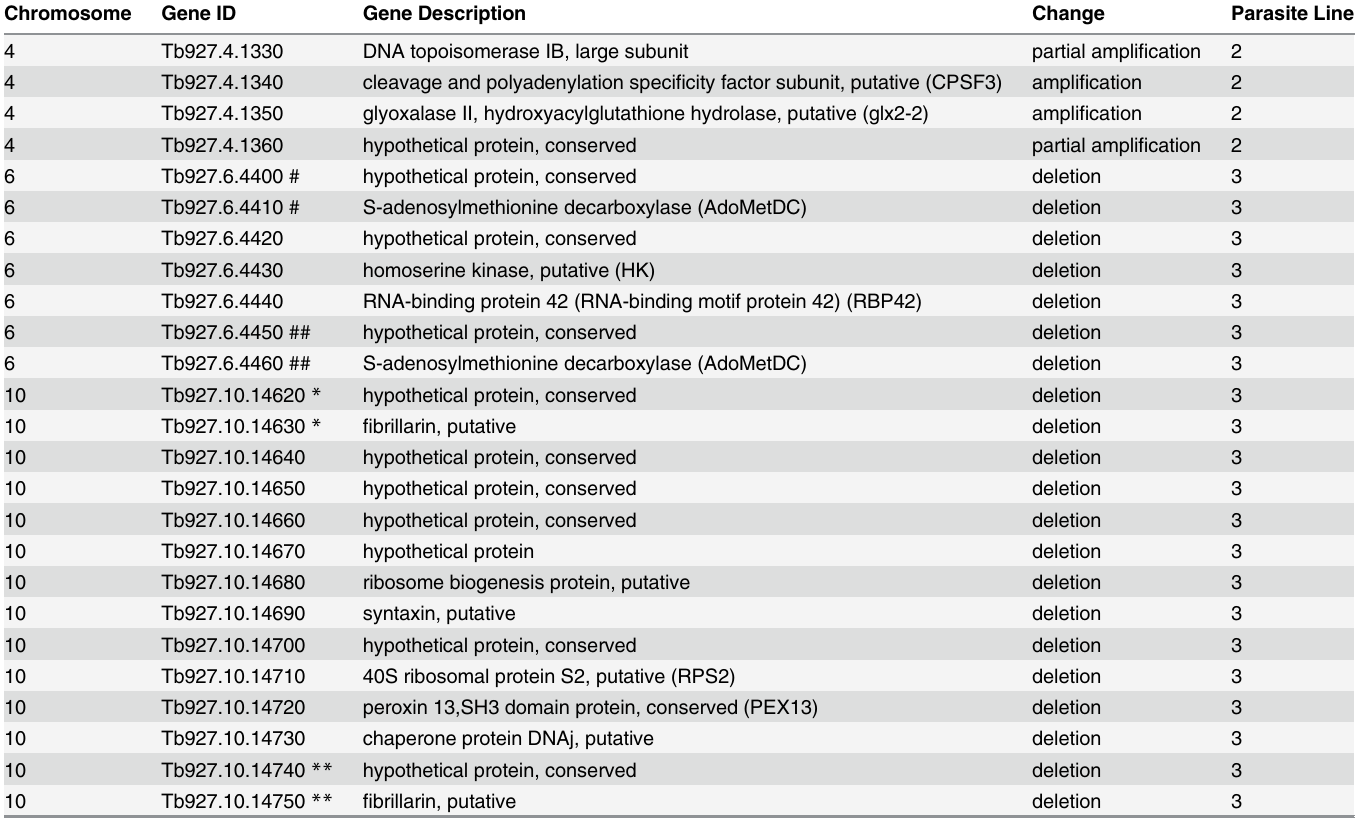
tion regulates a wide variety of cellular processes, including transcription, mitotic chromosome segregation, DNA replication and repair and ribosomal biogenesis [44,45] and offers an attrac- tive explanation for the chromosomal abnormalities described above. Knock down of SUMO /M phase of the cell cycle as observed here in procyclic forms of T . brucei results in arrest in G 2 [46]. In the case of clone 3, the SNP results in replacement of the initiator methionine residue with an isoleucine. Inspection of the flanking region of SUMO revealed no upstream in-frame methionine and the next downstream methionine is at residue 50 in this 114 amino acid pro- tein. Based on the solution structure of T . brucei SUMO [47], the truncated protein is likely to Table 2. Genes affected by copy number variations (CNVs) observed in the parasite lines. Chromosome Gene ID Gene Description Change Parasite Line